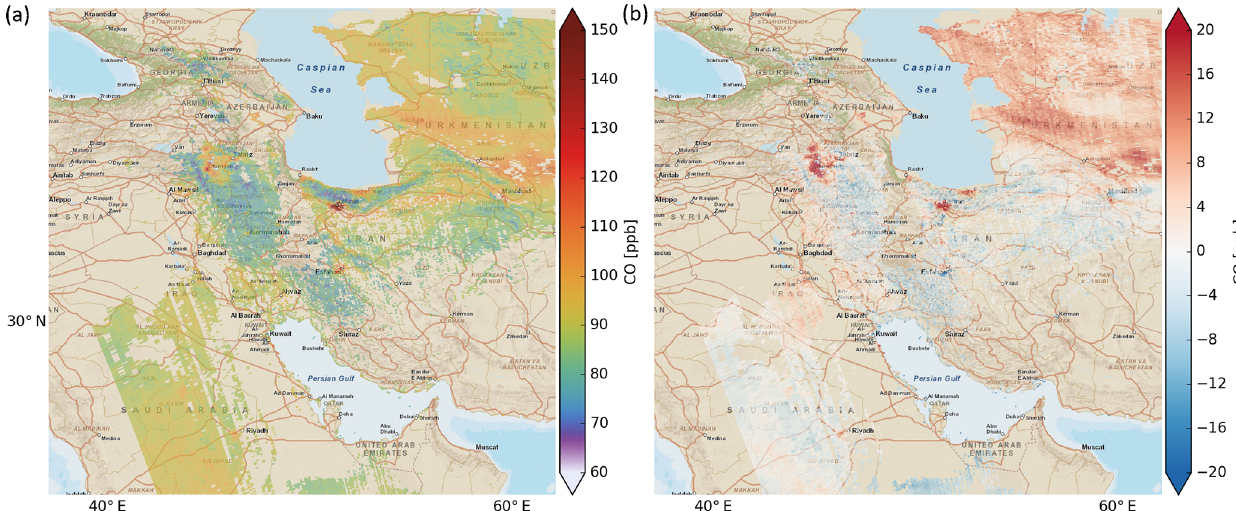
Figure 3. TROPOMI CO retrieval of one orbit on 18 December 2017 09:37UTC (a) and the difference (TROPOMI − WRF, b ).